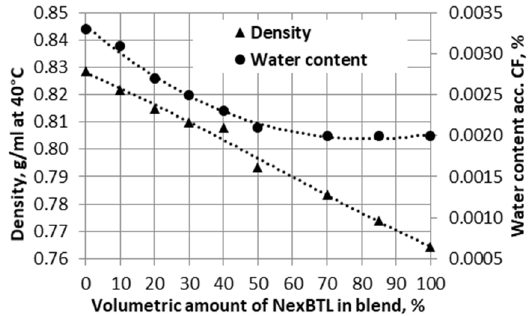
Figure 3. Dependence of the density (40 °C) and water content on the percentage of NexBTL in fuel blends.